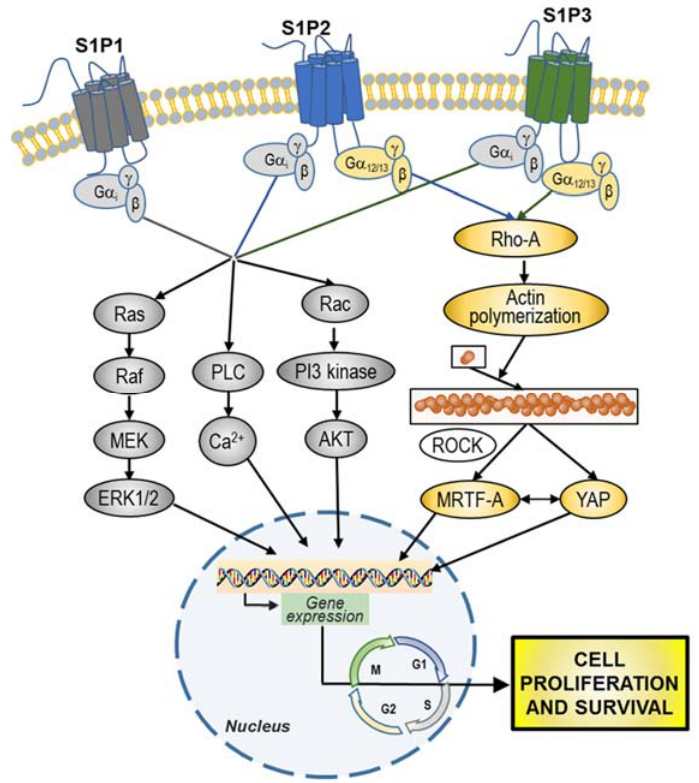
Figure 4. Overview of S1P-signaling pathways involved in GBM cell and GBM stem cells (GSC) proliferation and survival. S1P, through stimulation of i) G i may simultaneously activate MAPK-ERK1 / 2, phospholipase C (PLC), and phosphoinositide 3-kinase (PI3K) pathways; and ii) G 12 / 13 may promote actin polymerization through RhoA. Following the activation of downstream signaling pathways, S1P prompts the activation of di ff erent transcription factors, leading to the regulation of di ff erent genes involved in the promotion of cell proliferation and survival.